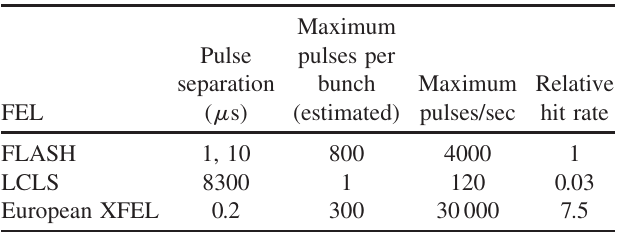
TABLE I. Relative hit rate for randomly injected samples with existing and projected XFEL facility pulse parameters, assuming an identical x-ray focus.